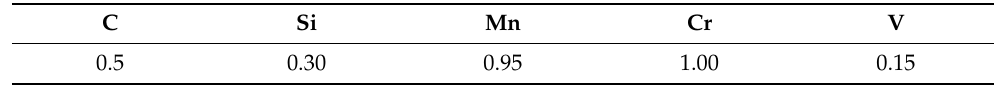
Table 1. Chemical composition of 51CrV4 steel in